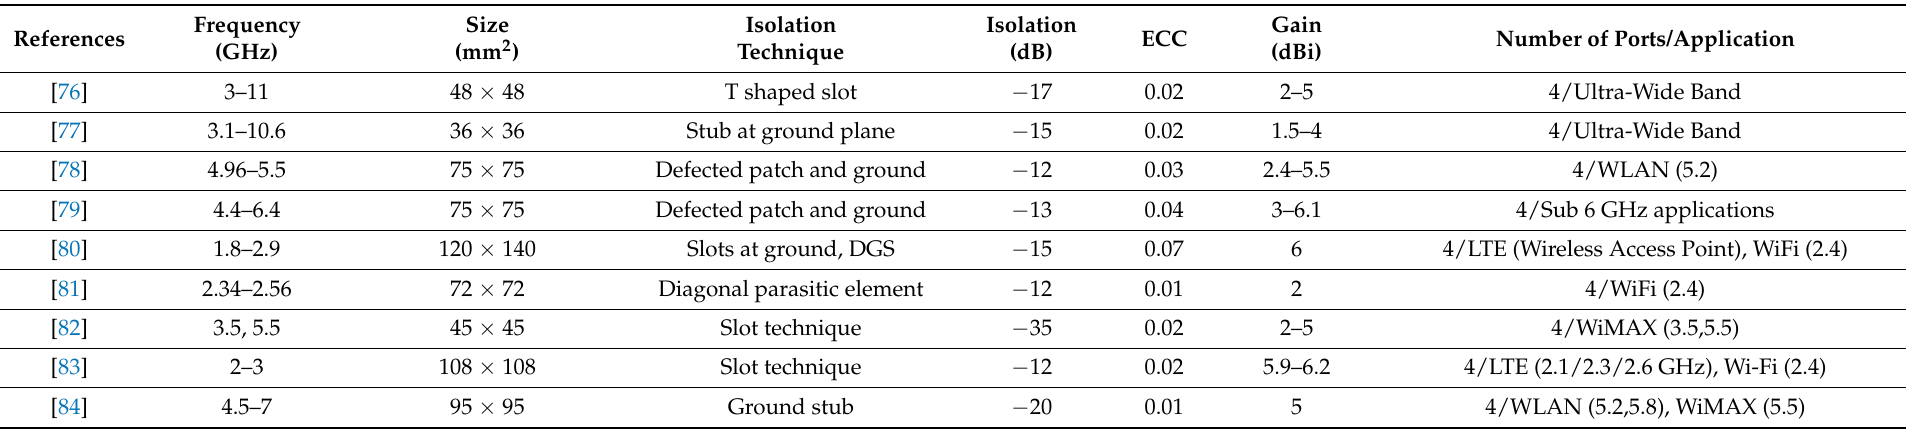
Table 3. Shared radiator antenna with four